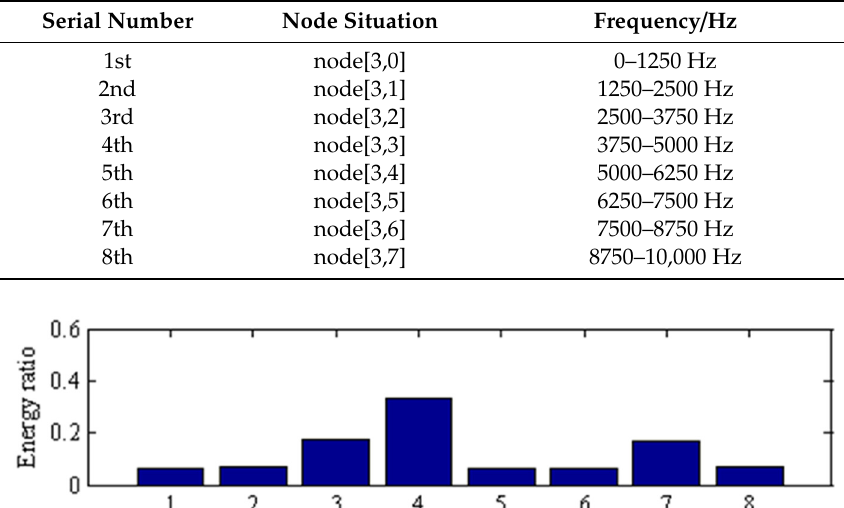
Table 2. The frequency range of three layer wavelet packet decomposition.